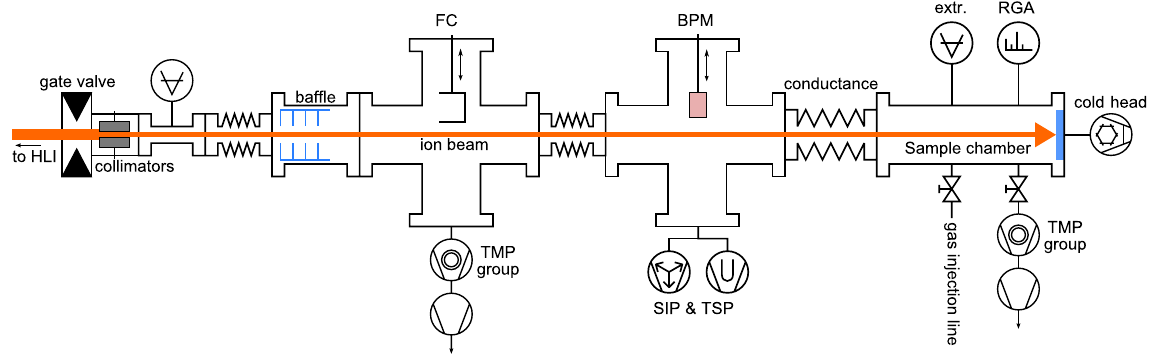
FIG. 1. Schematic view of the experimental setup, which has been attached at the GSI HLI for heavy-ion-induced desorption measurements at 1 : 4 MeV = u